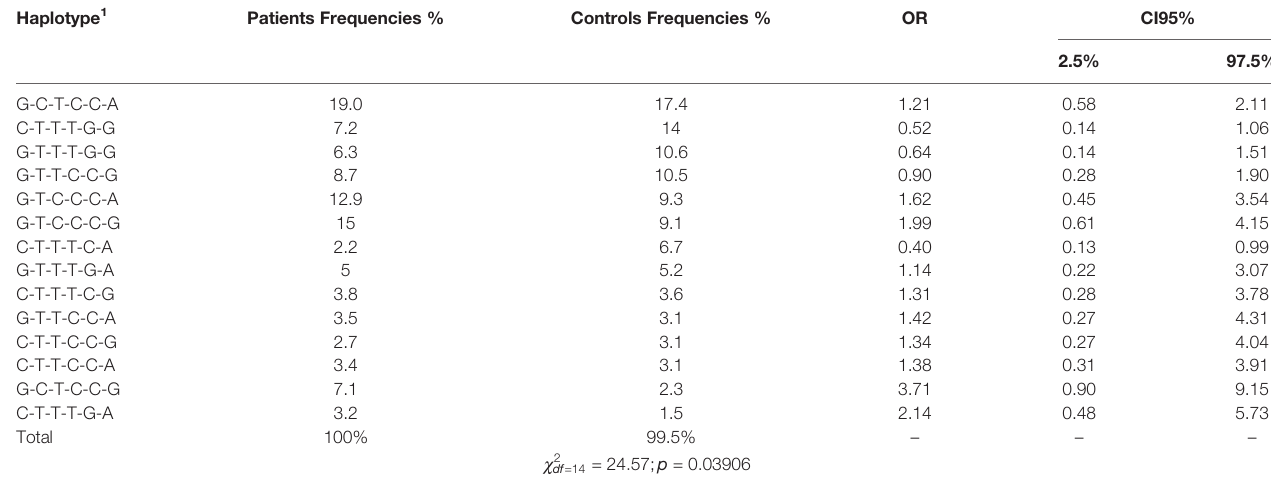
TABLE 4 | Haplotype frequencies in cases and control group among never-smokers. Haplotypes were sorted by control frequencies. Haplotype 1 Patients Frequencies % Controls Frequencies